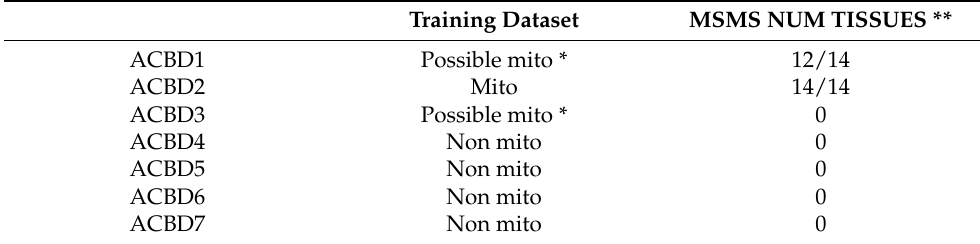
Table A2. Expression level of ACBDs proteins according to MitoCarta 2.0.